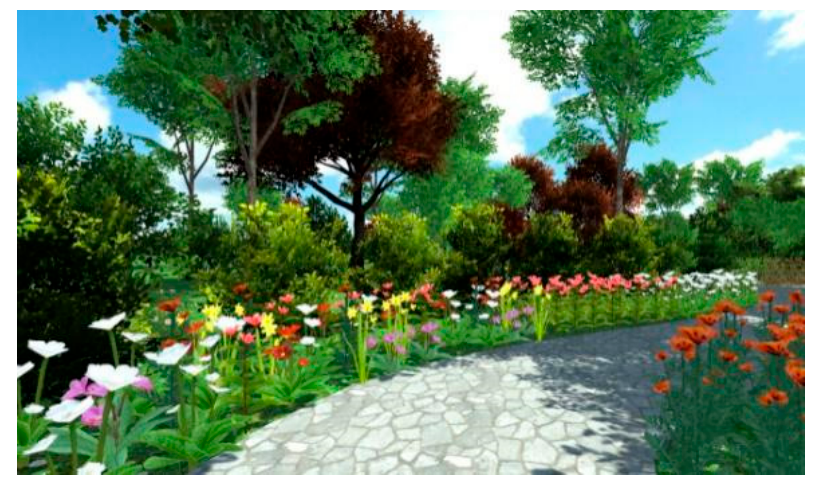
Figure 6. Screenshot 1 of a restorative garden scene.